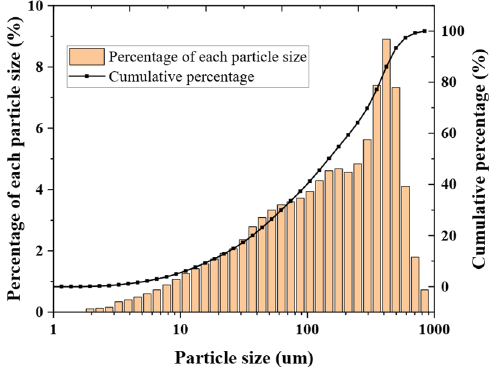
Figure 6. Laser particle size distribution of coal sample for test.